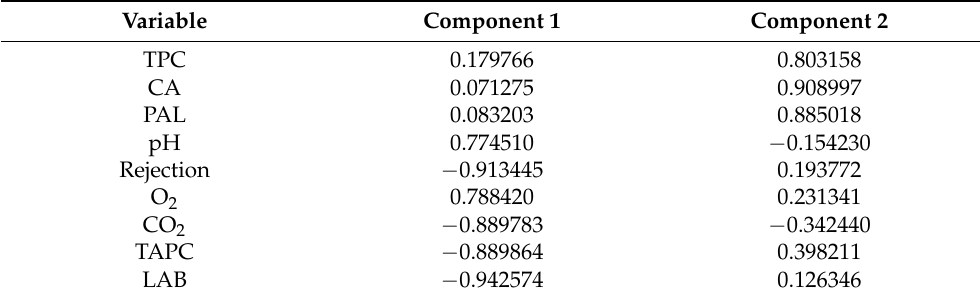
Figure 2. Principal component analysis (PCA) of fresh-cut carrots as affected by abiotic stress treatments and packaging film during low-temperature storage (5 ◦ C, 14 days): ( a ) loading plot and ( b ) score plot. Table 2. Factor loadings of the principal component analysis (PCA) based on a correlation matrix between nine quality parameters of FC carrots (56